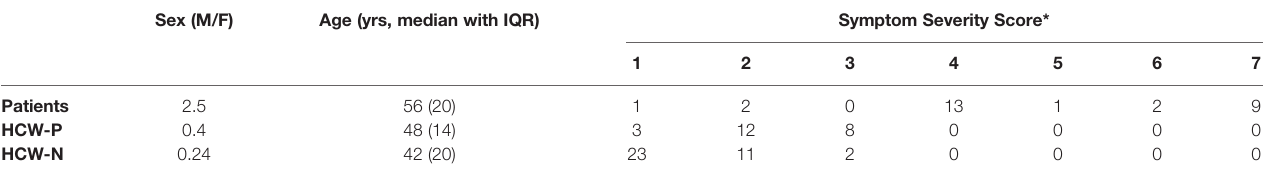
TABLE 2 | Cohort demographic and severity score classi fi cation.